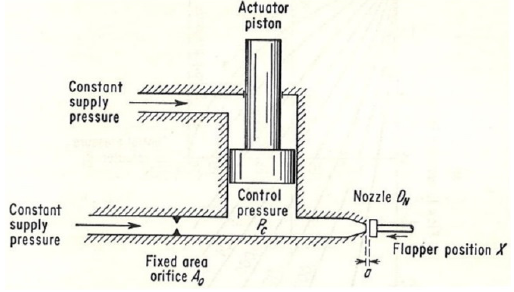
Figure 2. Flapper-nozzle servo valve [6].